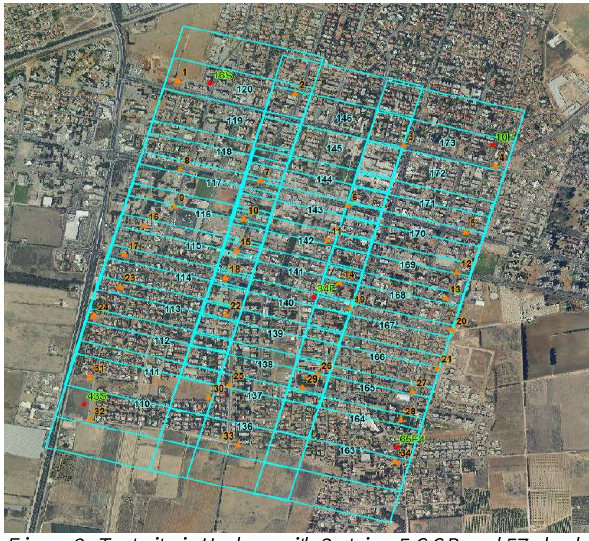
Figure 2: Test site in Hedara with 3 strips, 5 GCP and 57 check points